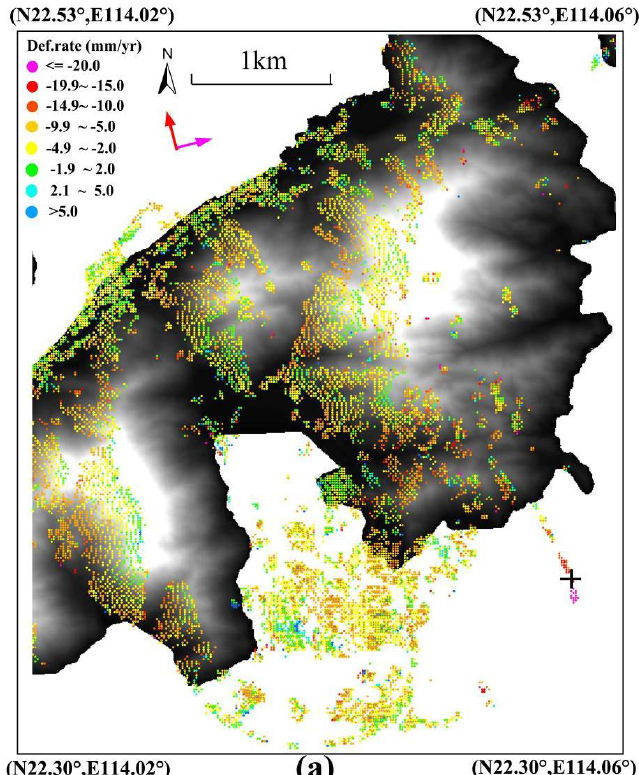
Figure 6. SB-InSAR derived LOS surface annual motion rates over Disneyland region superimposed on the DEM-shade imagery. The black cross indicates the location of a coherent pixel (CP) for time series comparison shown in Section 5.3, the red and pink arrows indicate the satellite flight path and looking direction of line of sight, respectively; ( a ) PALSAR for the observation period from June 2007 to January 2011; ( b ) TerraSAR for the observation period from October 2008 to December